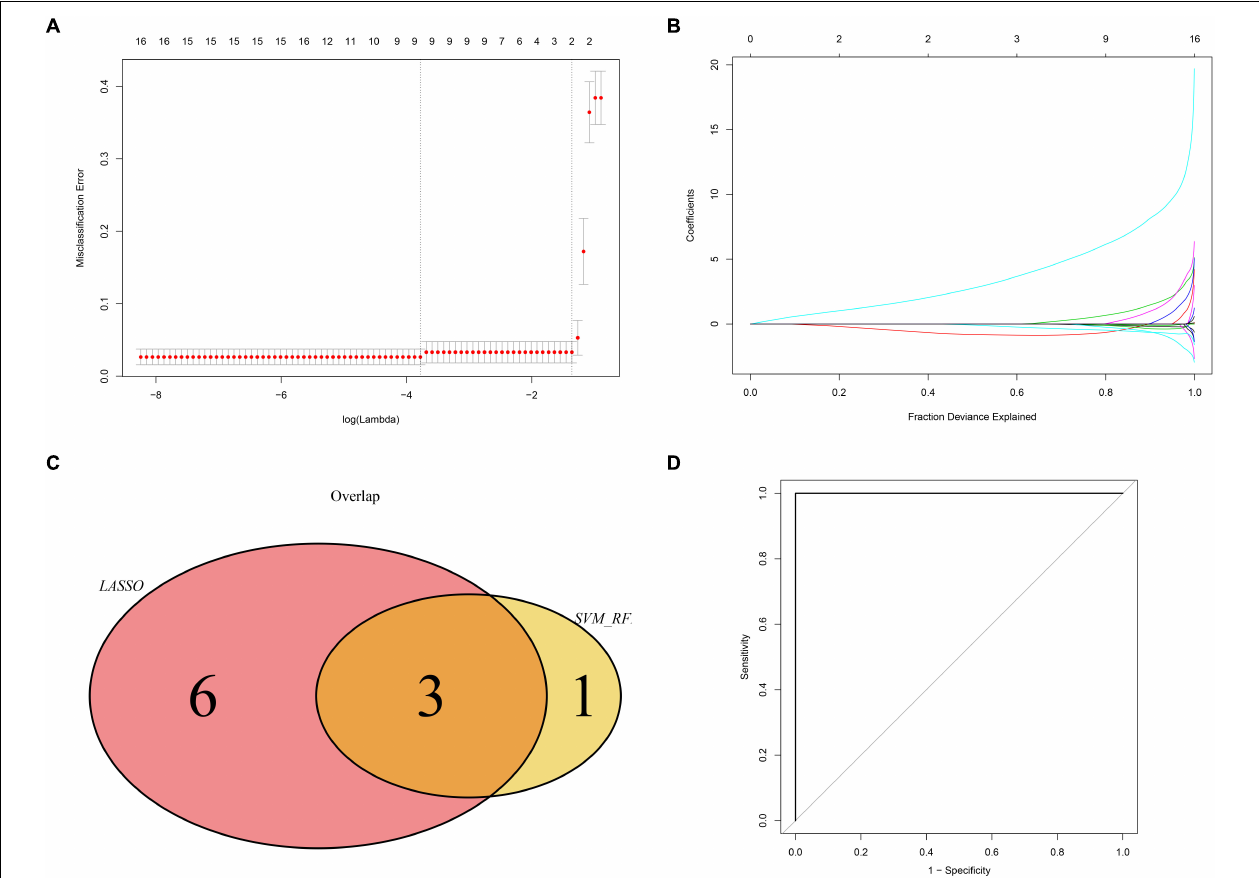
FIGURE 9 | Screening and validation of biomarkers. (A) L1-penalty of Least absolute shrinkage and selection operator (LASSO) regression. The dotted vertical lines denote the optimal value: 9. (B) LASSO coefficient values of the sub networks genes. (C) The Venn graph shows the interaction between LASSO and SVM-RFE algorithm. (D) Validation of the diagnostic value in the external dataset by using receiver operating characteristic curve (ROC) analysis.